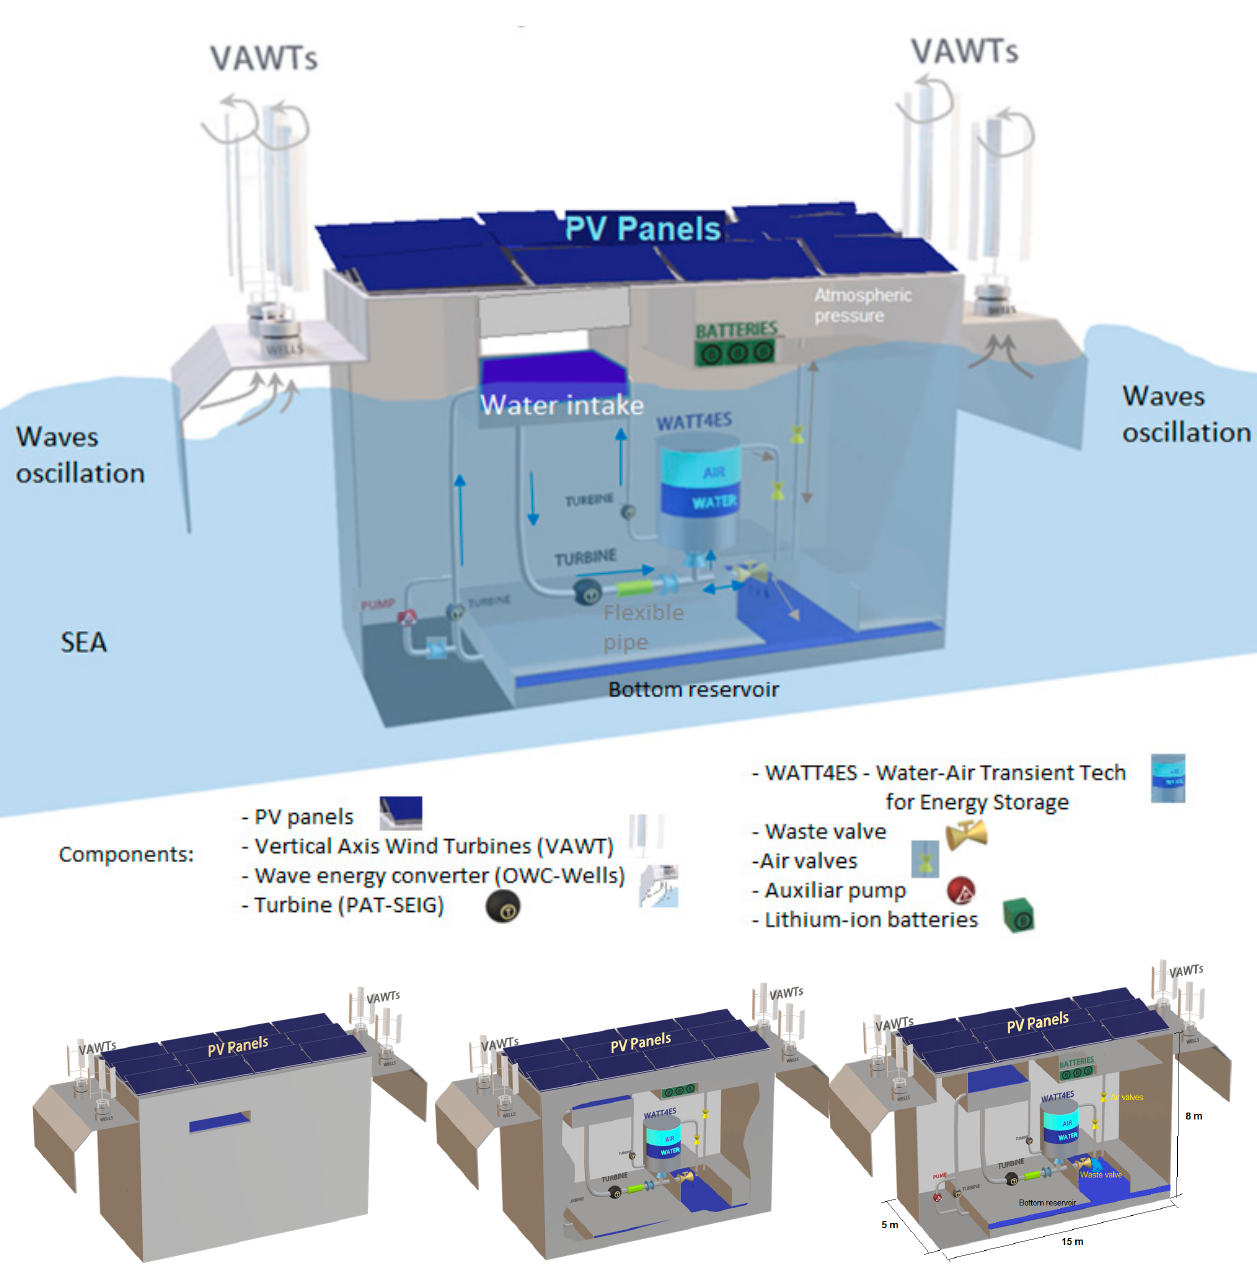
Figure 23. New concept of integrated energy solution module: innovative Hy4REN offshore solution ( top ), module visualization from outside to inside ( bottom ).